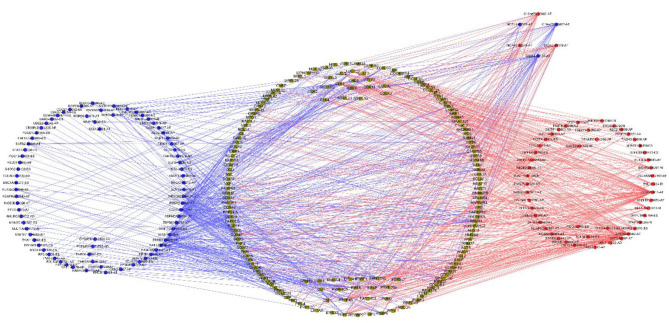
Correlation network of RBPs and OS-ASEs. The yellow dots represent RBPs. The blue and red dots indicate OS-ASEs that have been negatively regulated or positively regulated by the corresponding RBPs. The blue and red lines represent the existence of negative or positive regulation effects.